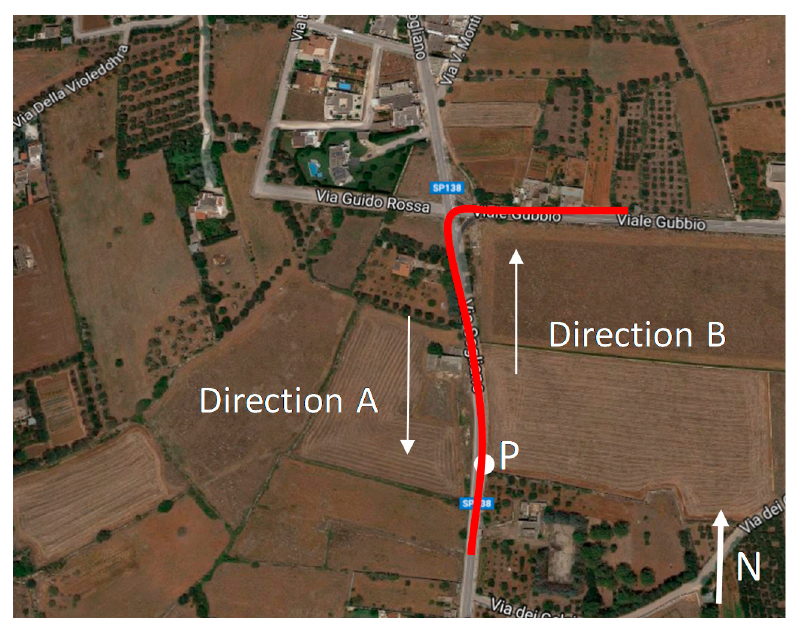
Figure 2. Monitored traffic scenario (photo: Google maps).